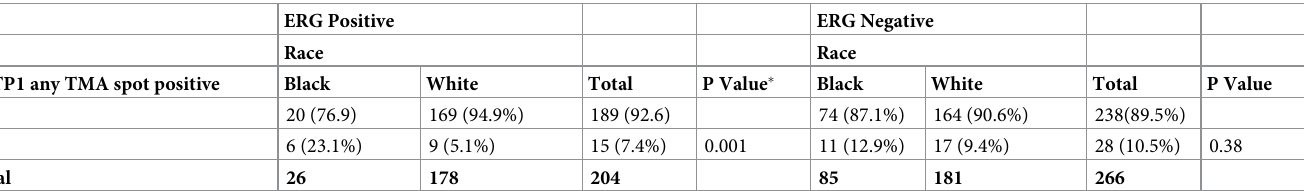
Table 6. GSTP1 protein staining by ERG status in Black and White patients.